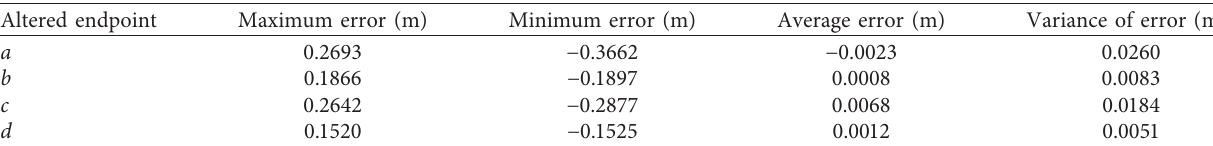
Figure 6: Distribution of space headway estimation errors when the locating offset of only one calibration pattern endpoint is changed: (a) endpoint a , (b) endpoint c , (c) endpoint b , and (d) endpoint d The four subfigures are placed in the order of their corresponding points in the calibration pattern in the image; that is, point c is the endpoint at the upper right corner, and point b is at the lower left corner. Table 1: Characteristics of space headway estimation errors when the locating offset of only one calibration pattern endpoint is